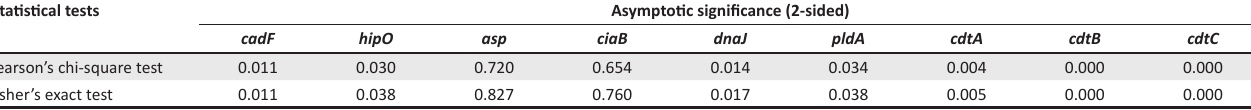
TABLE 3: Chi-square test and Fisher’s exact test for virulence genes investigated.